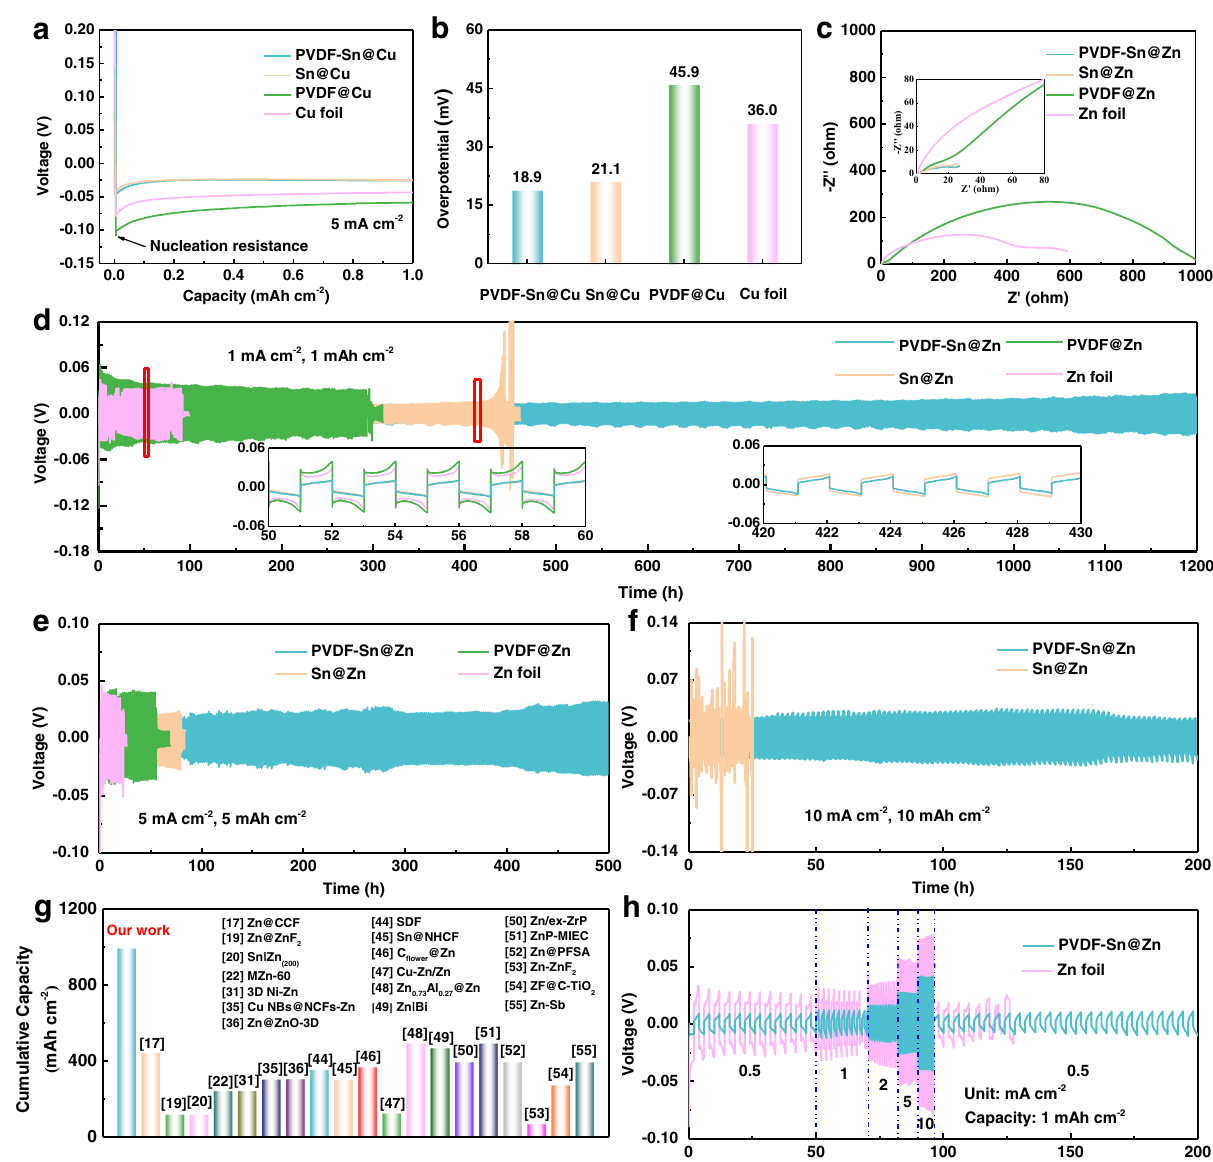
Fig.5|Theelectrochemicalperformanceofdifferentelectrodes.a Voltage – time curvesforZndepositionat5mAcm − 2 ondifferentelectrodes. b ThesummaryofZn nucleation overpotentials for different electrodes. c EIS plots of the symmetrical cellsassembledbydifferentelectrodes.Voltagepro fi lesofZn//Znsymmetricalcells atcurrent densities/capacities of d 1mAcm − 2 /1mAhcm − 2 , e 5mAcm − 2 /5mAhcm − 2 ,